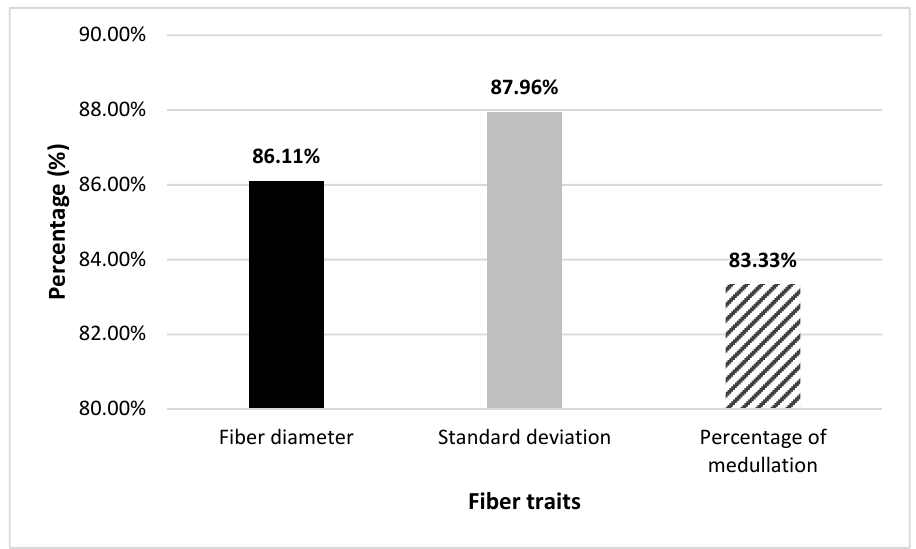
Figure 1. Percentage of same selected animals for fiber diameter (FD), standard deviation (SD) and percentage of medullation (PM) using BLUP and ssGBLUP methods by truncation selection of top 25%.